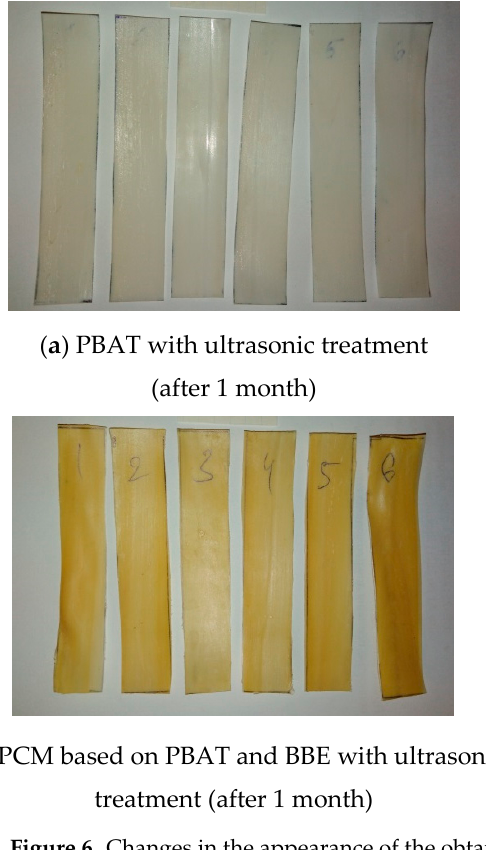
Figure 6. Changes in the appearance of the obtained PCM samples during the composting period. Table 7. Results of determining the degree of biodegradation of the studied